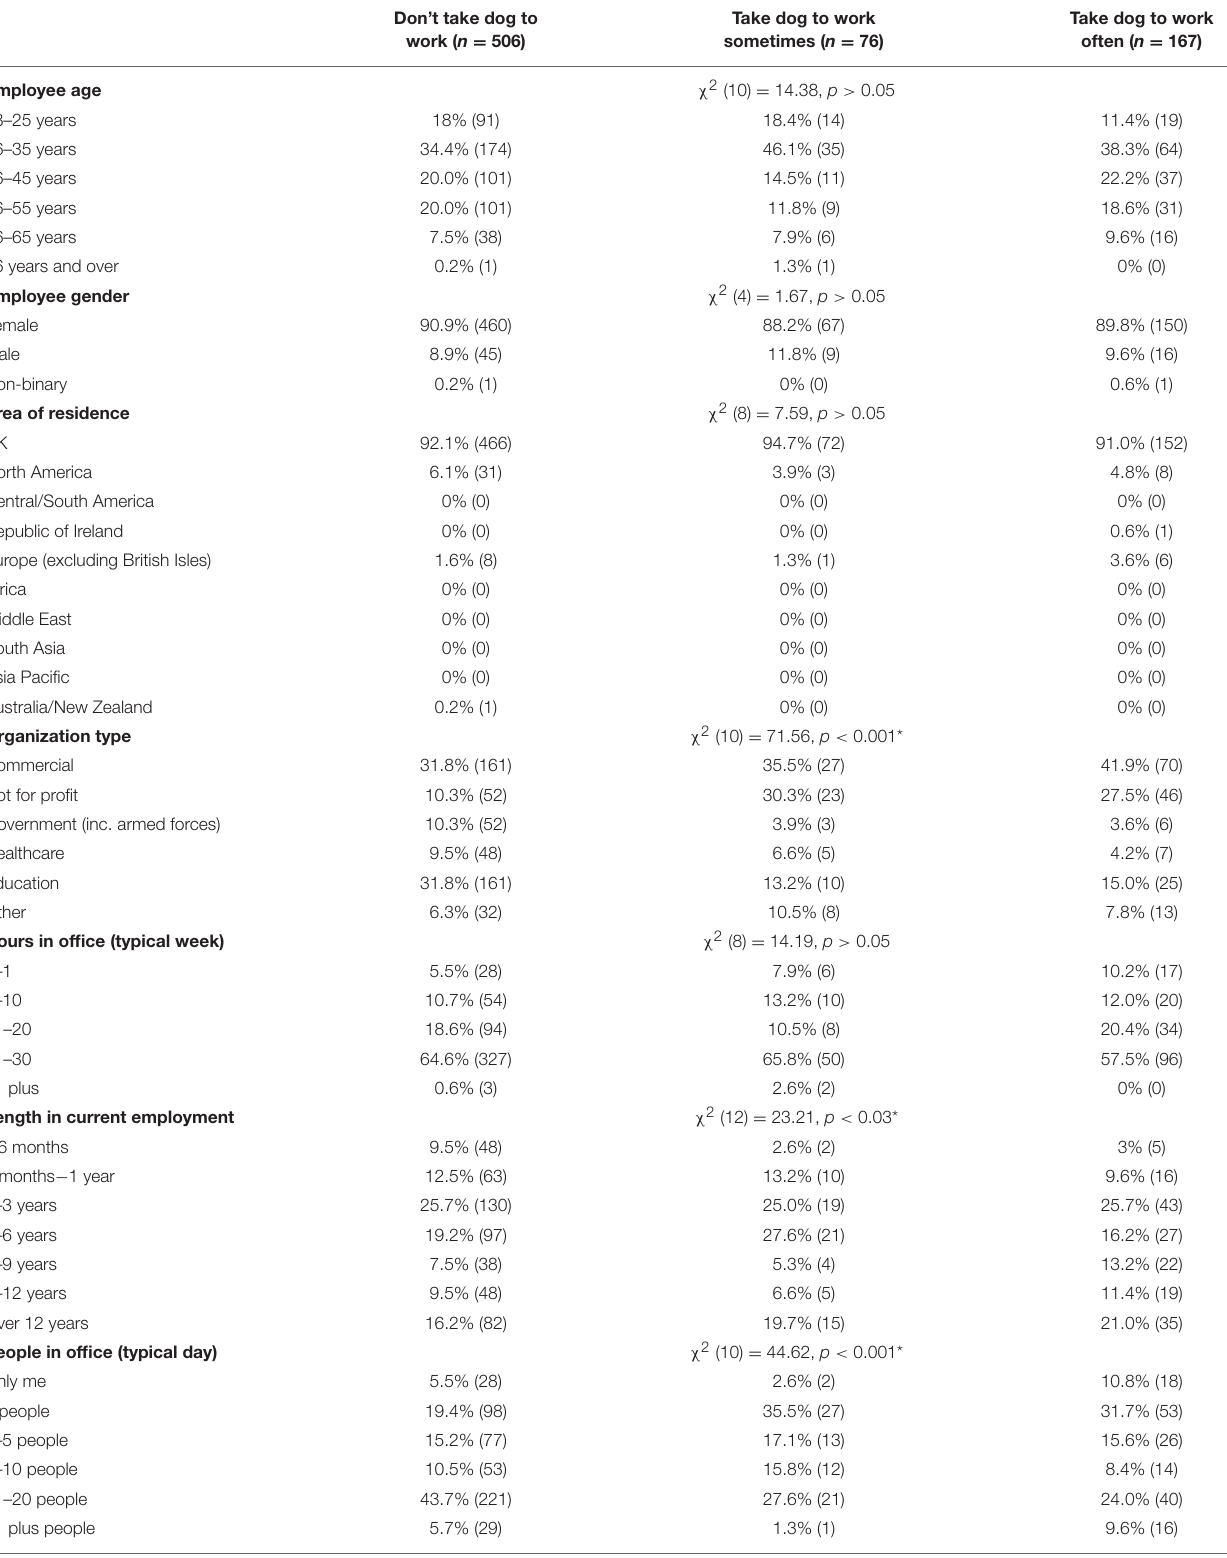
TABLE 1 | Demographic items and responses across